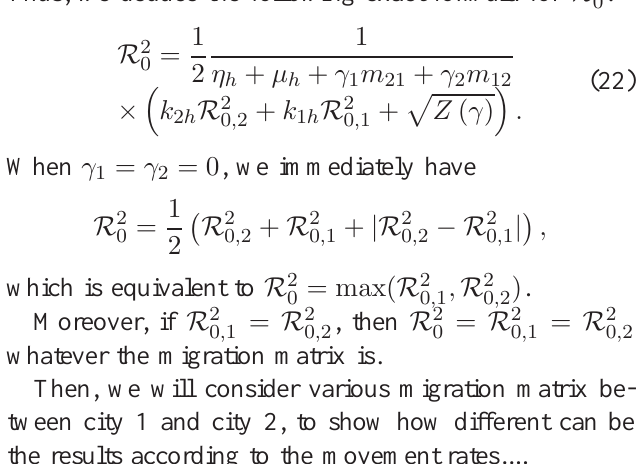
Fig. 2. Simulation of the evolution of the infected population per week for different values of γ = γ 1 = γ 2 .